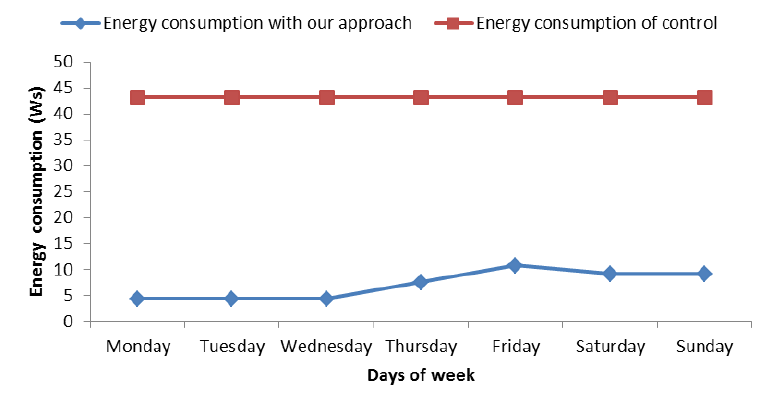
Figure 11. Energy consumption from 7 May to 13 May.